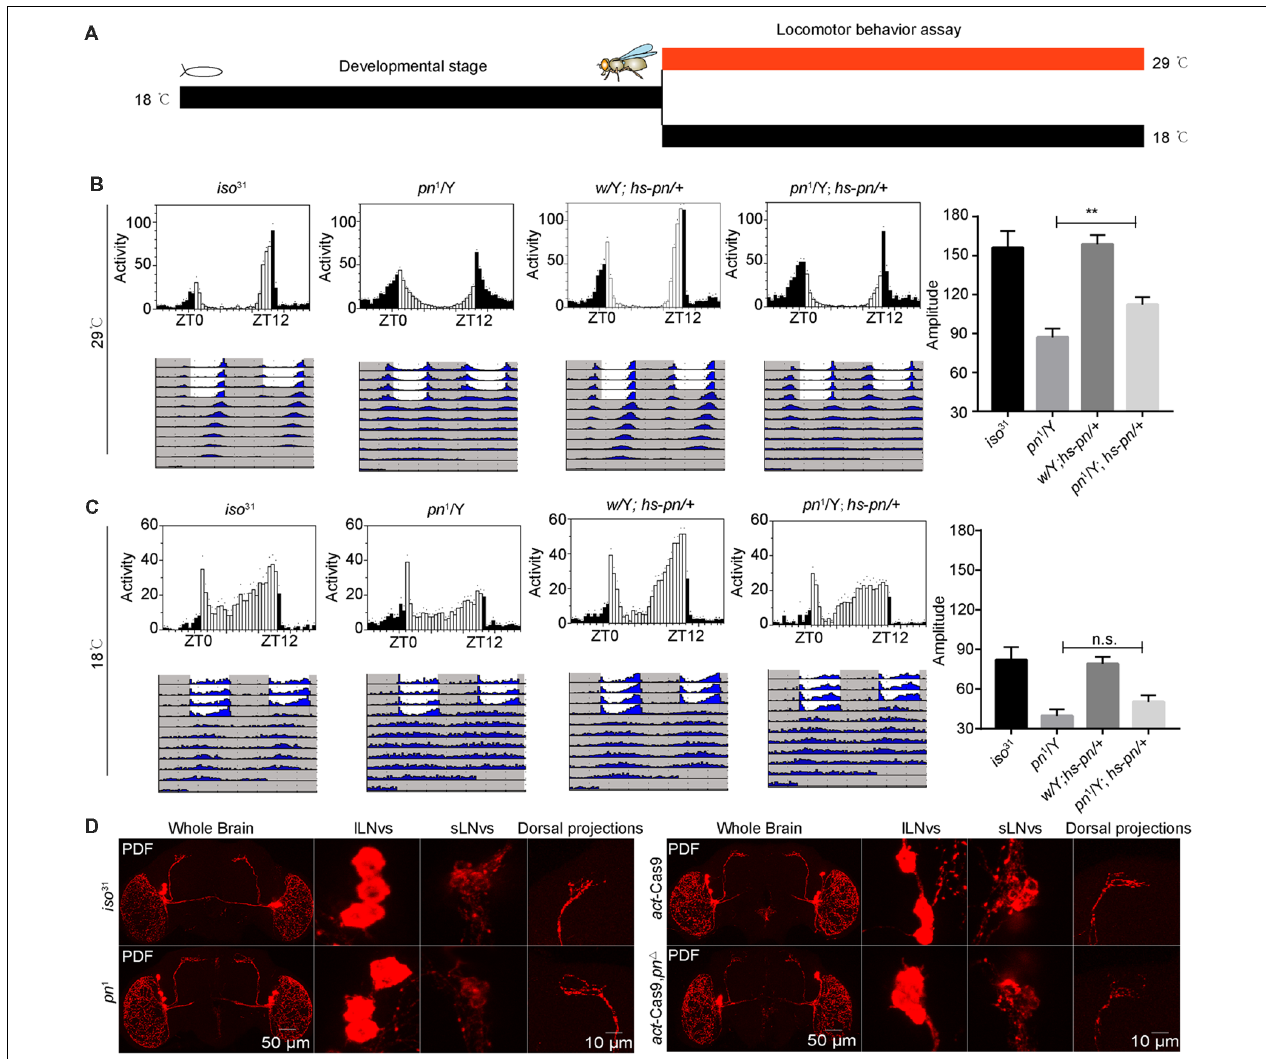
FIGURE 2 | Pn functional in adulthood to maintain the amplitude of the circadian rhythm. (A) A schematic to show adulthood specific rescue experiments. The flies were reared at 18 ◦ C, and then were either transferred to 29 ◦ C or kept at the low temperature, and a locomotor activity behavior assay was performed at eclosion. (B) Averaged activity profiles and amplitude analysis of flies transferred to 29 ◦ C. (C) Averaged activity profiles and amplitude analysis of flies maintained at 18 ◦ C. White bars represent day, black bars represent night, ZT is indicated on the x axes. The dots above the bars indicate SEM. The period and amplitude are shown as means ± SEM ( n = 30–48). ∗∗ P < 0.01, n.s. no significance. At least three independent repeats were performed. (D) pn 1 , pn (cid:52) mutant and control brains stained with PDF demonstrate that development of ventral lateral neurons (LNvs) and dorsal projections are normal ( n =